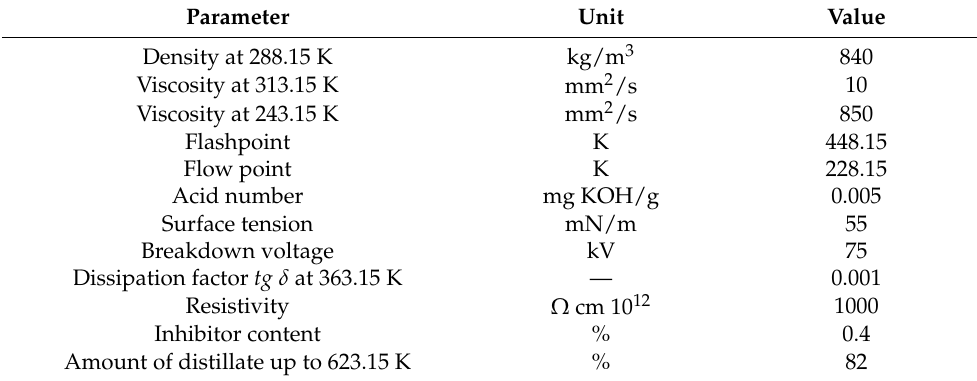
Table 1. Characteristic parameters of MO oil. Adapted from [33].